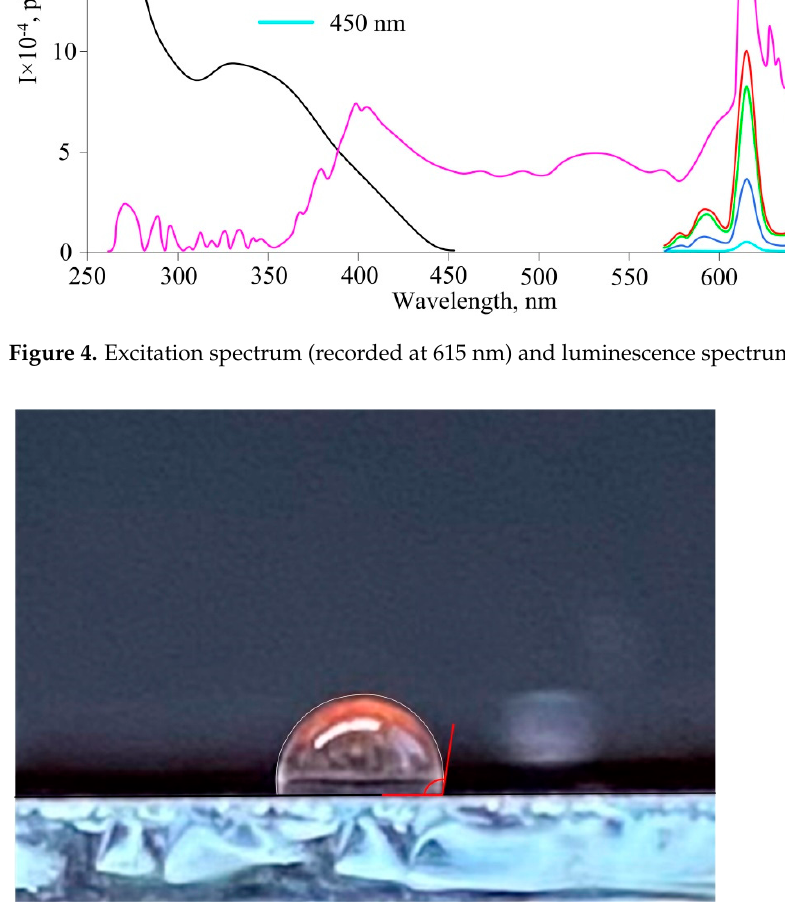
Figure 5. A picture of a drop of water on the surface of the compound 4 .